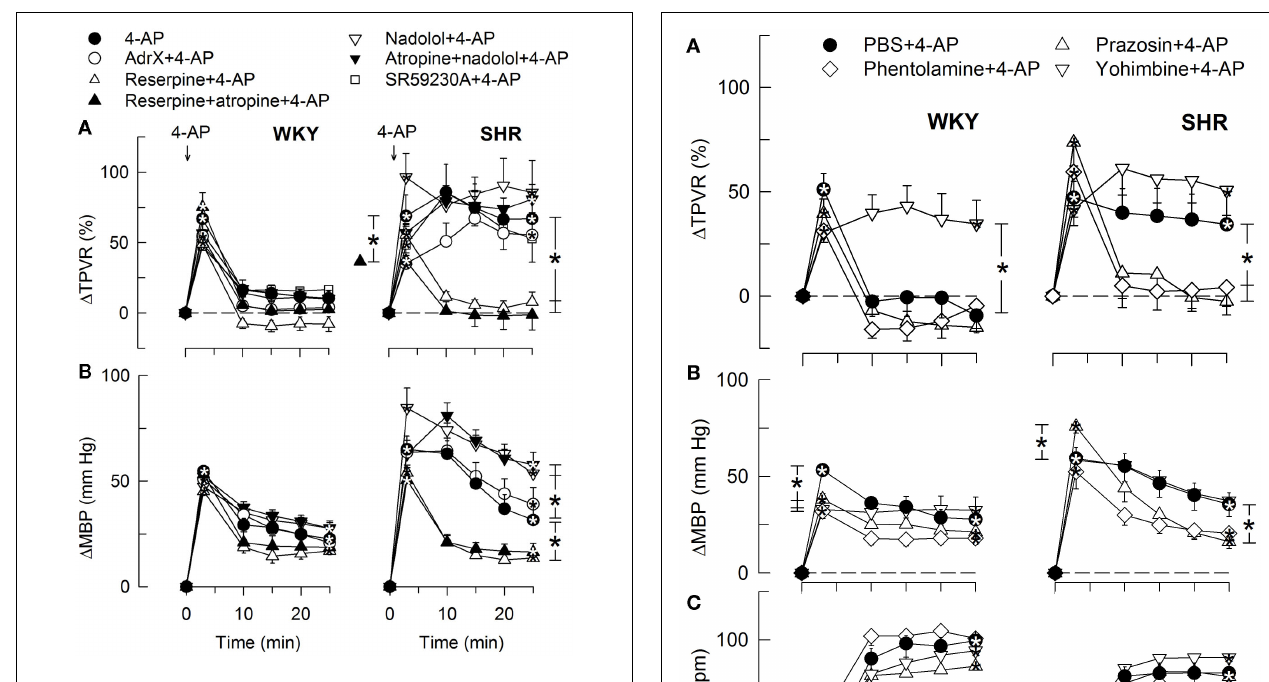
FIGURE 8 |TheTPVR- (A) and MBP- (B) response to 4-AP after blockade of components of the adrenergic system. Adrenal catecholamines were eliminated by AdrX, neuronal norepinephrine by reserpine, β 1 + 2 AR activity with the peripherally restricted antagonist nadolol, and β 3 AR-activity with the β 3 AR antagonist SR59230A. Reserpine and nadolol were given alone or combined with mAChR antagonist (atropine), as indicated by symbol legends. Significant responses (* within symbol) and group differences (brackets) were located as indicated. BaselineTPVR was higher in AdrX SHR, and reduced after reserpine, reserpine + atropine, and nadolol + atropine in SHR. MBP was lower after reserpine inWKY ( Table 2 ). * – P ≤ 0.025.